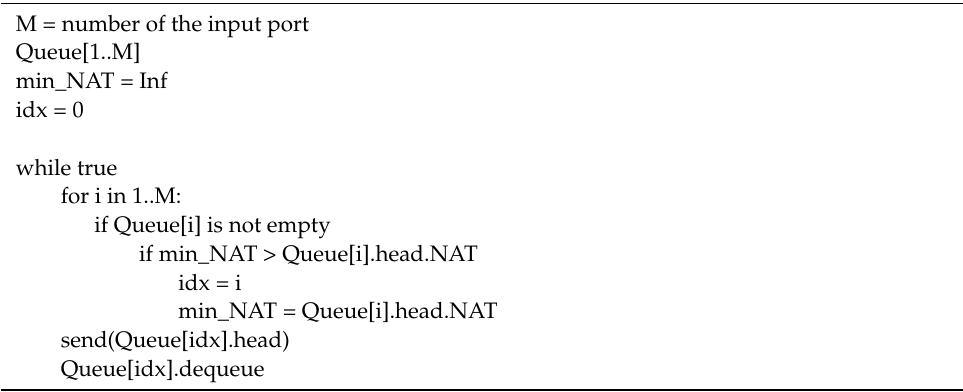
Algorithm 2. NAT-HA in the output port